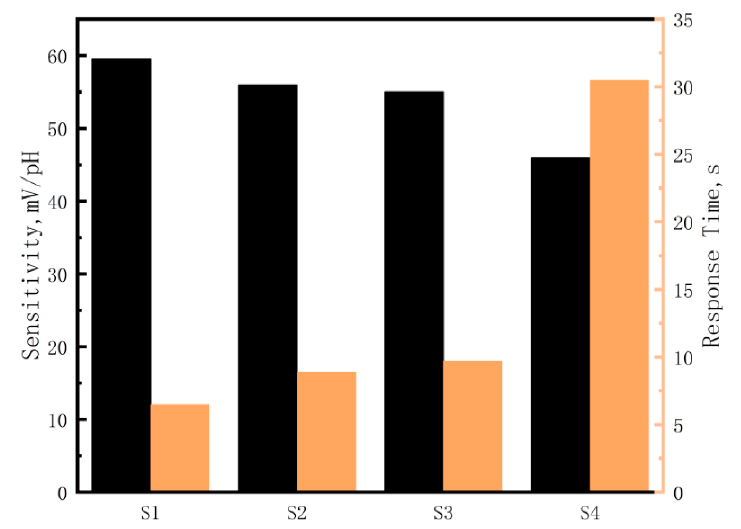
Figure 4. The surface morphology of iridium oxide films prepared at oxygen flow rates of ( a ) 10 sccm, ( b ) 20 sccm, ( c ) 30 sccm, and ( d ) 40 sccm; the Ar flow rate was maintained at 10 sccm during preparation, and the sputtering time was 15 min.